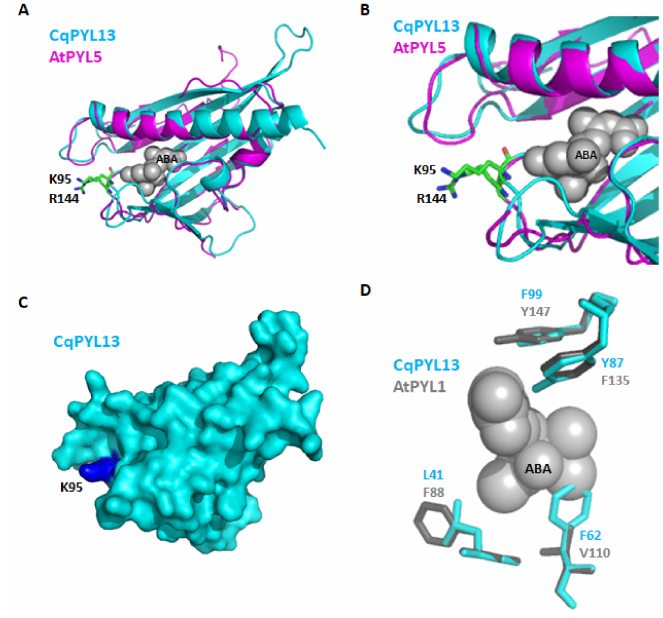
Figure 9. CqPYL13 topology analysis. ( A ). Structural alignment of CqPYL13 and AtPYL5. Protein structures were showed as cartoons. Residue K95 from CqPYL13 and R144 from AtPYL5 were indicated. ( B ) close-up from panel A. ( C ) CqPYL13 topology showed as surface. ( D ) Structural alignment of CqPYL13 and AtPYL1. Some protein residues from the ABA pocket were indicated and showed as stick view.